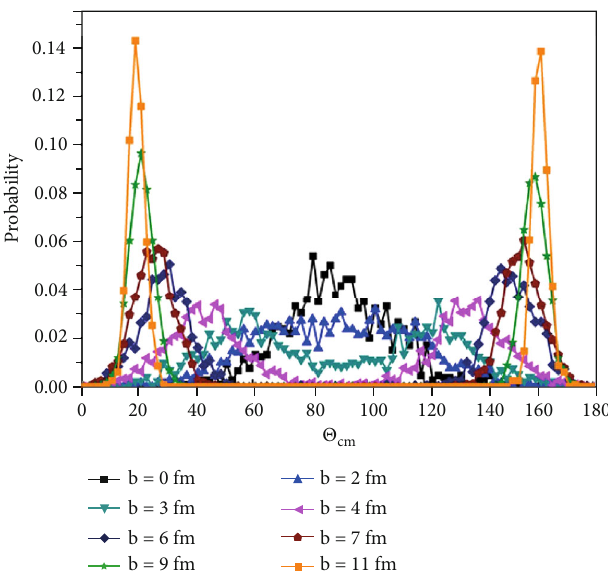
on the impact parameter with respect to sequential ternary fi ssions in 197 Au cm